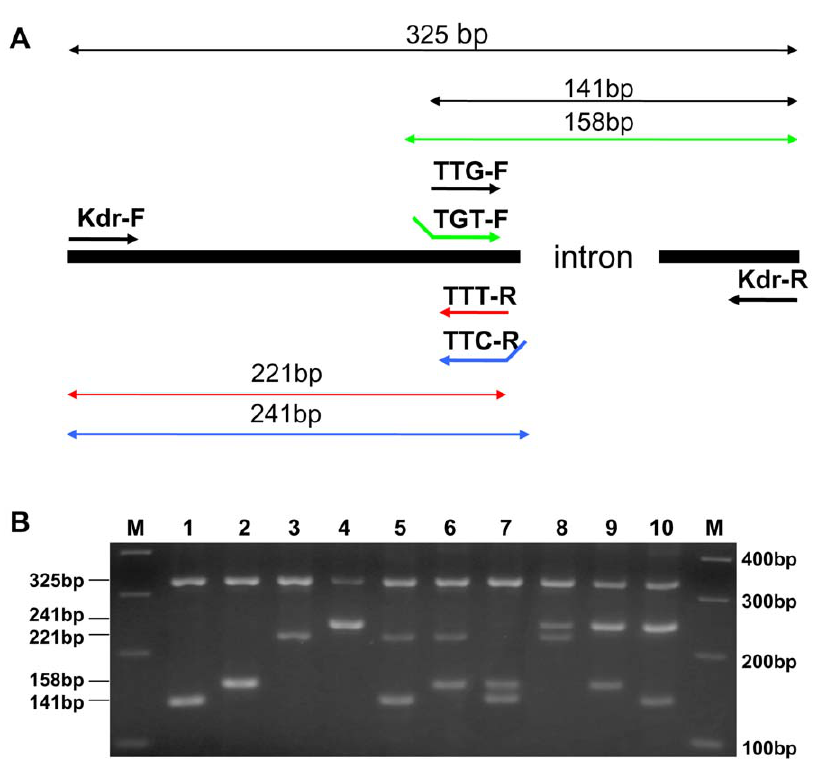
Figure 4. Allele-specific PCR (AS-PCR) for kdr genotyping in Anophelessinensis . A: Schematic representation of the primer location and predicted size of the PCR product. Arrow indicated the location of PCR primers in which sequences are reported in Table 1. Primer pair TTG-F and kdr - R amplifies a 141 bp fragment for the wildtype allele (for codon TTG). Primer pair TGT-F/ kdr -R yields a 158 bp fragment for L1014C allele (codon TTC). Similarly, primer pair kdr -F/TTT-R and kdr -F/TTC-R leads to amplification of a 221 bp and 241 bp fragment diagnostic to the L1014F allele (for codon TTT and TTC), respectively. B: An example of AS-PCR gel electrophoresis. Lane M: 100 bp DNA ladder; lanes 1–4: homozygote for the codons TTG, TGT, TTT, and TTC, respectively; lanes 5–10: six heterozygous individuals (TTG/TTT, TGT/TTT, TTG/TGT, TTT/TTC, TGT/TTC, and